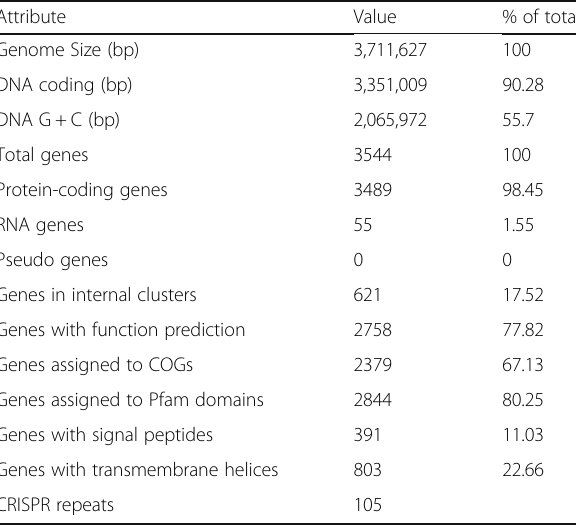
Table 3 Genome sequencing statistics of the A. paucihalophilus TH1 – 2 T genome